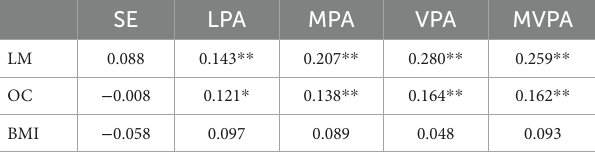
* Represents p < 0.05, ** represents p < 0.01.